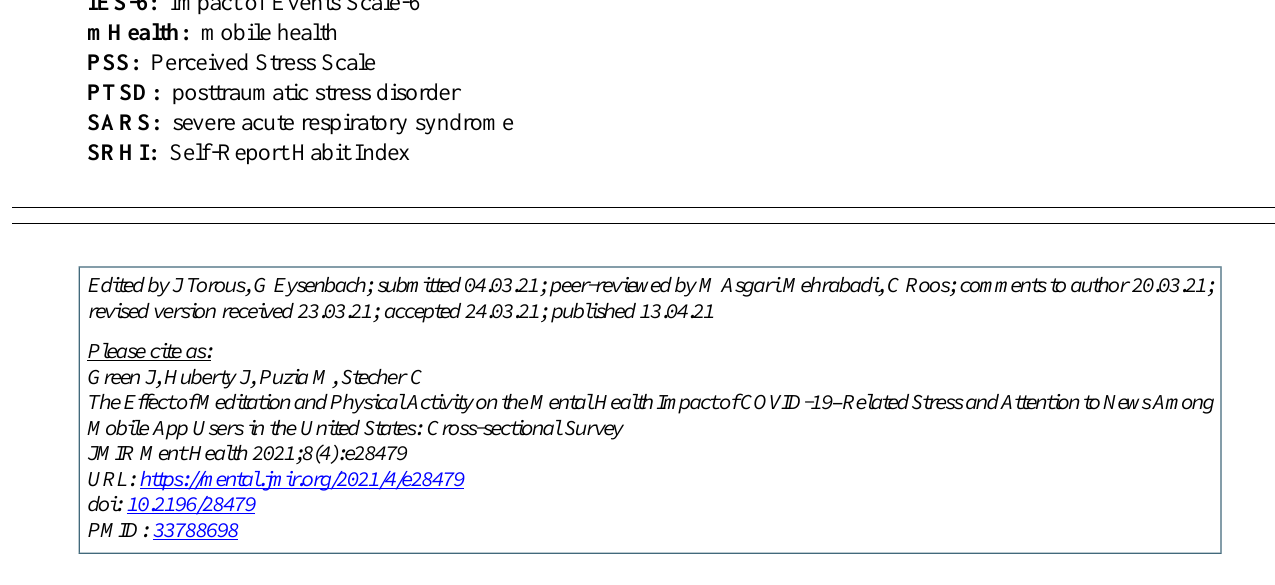
PSS: Perceived Stress Scale PTSD: posttraumatic stress